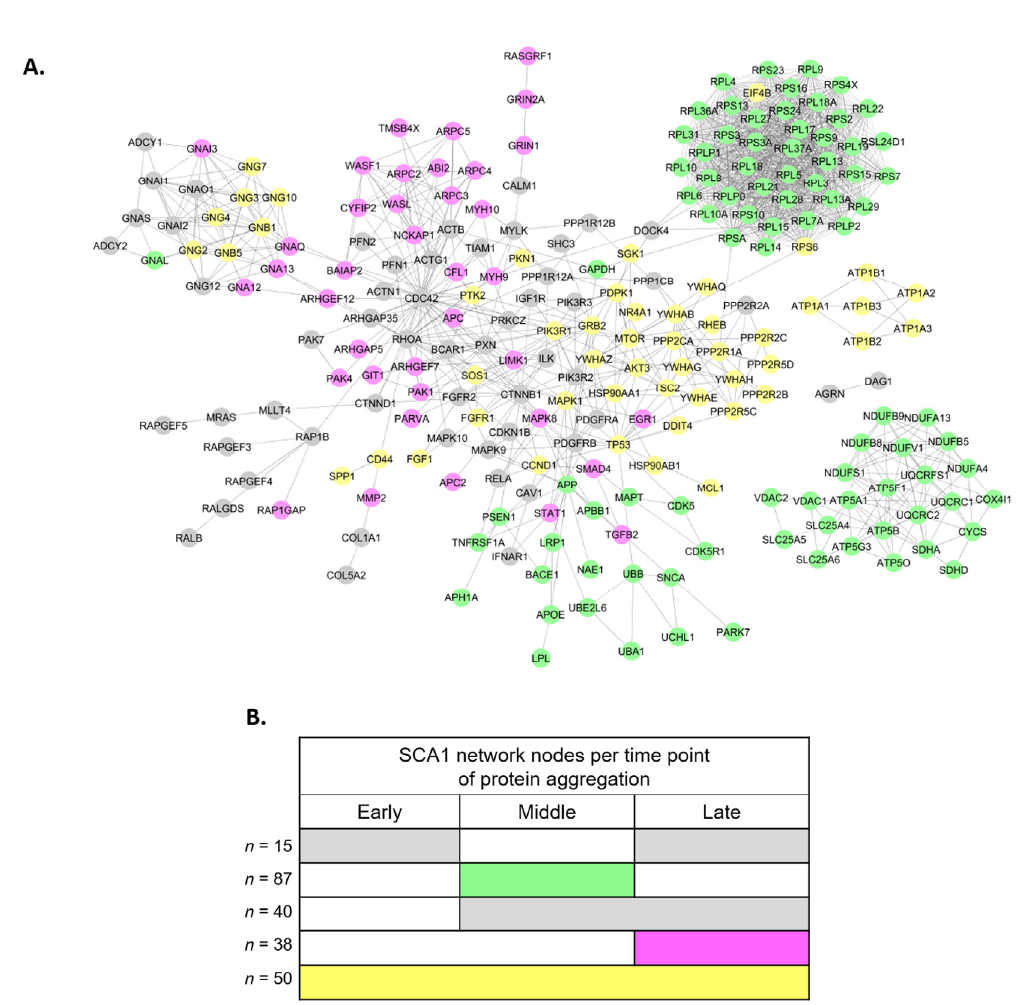
Figure 2. SCA1 disease PPI network. ( A ) The network contains 230 nodes (proteins) and 1432 edges (interactions). Green and magenta nodes are dysregulated at middle and late stage of protein aggregation, respectively. Yellow color indicates nodes that are dysregulated at all time-points. The network was constructed using the STRING database in Cytoscape. ( B ) Gannt chart indicating the different groups of nodes in the SCA1 disease network. Colors indicate the same groups as in ( A ).